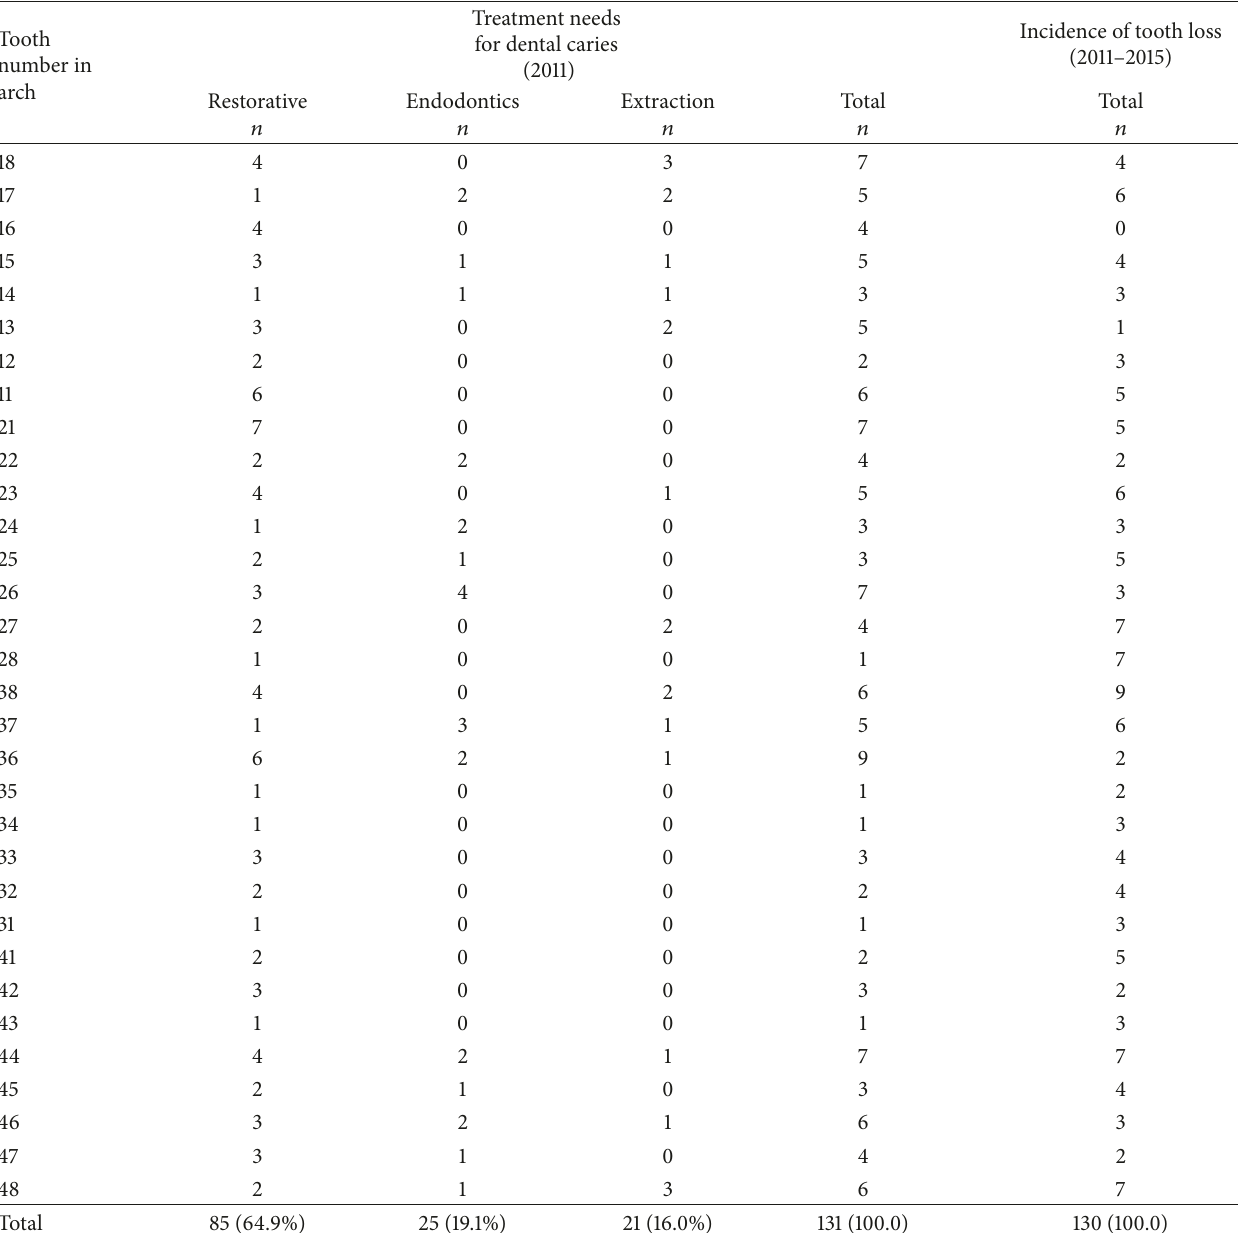
Among adults with incidence ( 𝑛 = 51 )